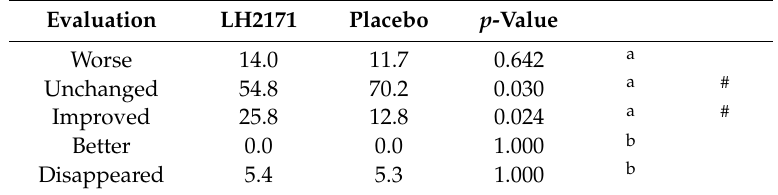
Table 4. The ratio of changes in the severity of allergic symptoms from 0 to 16